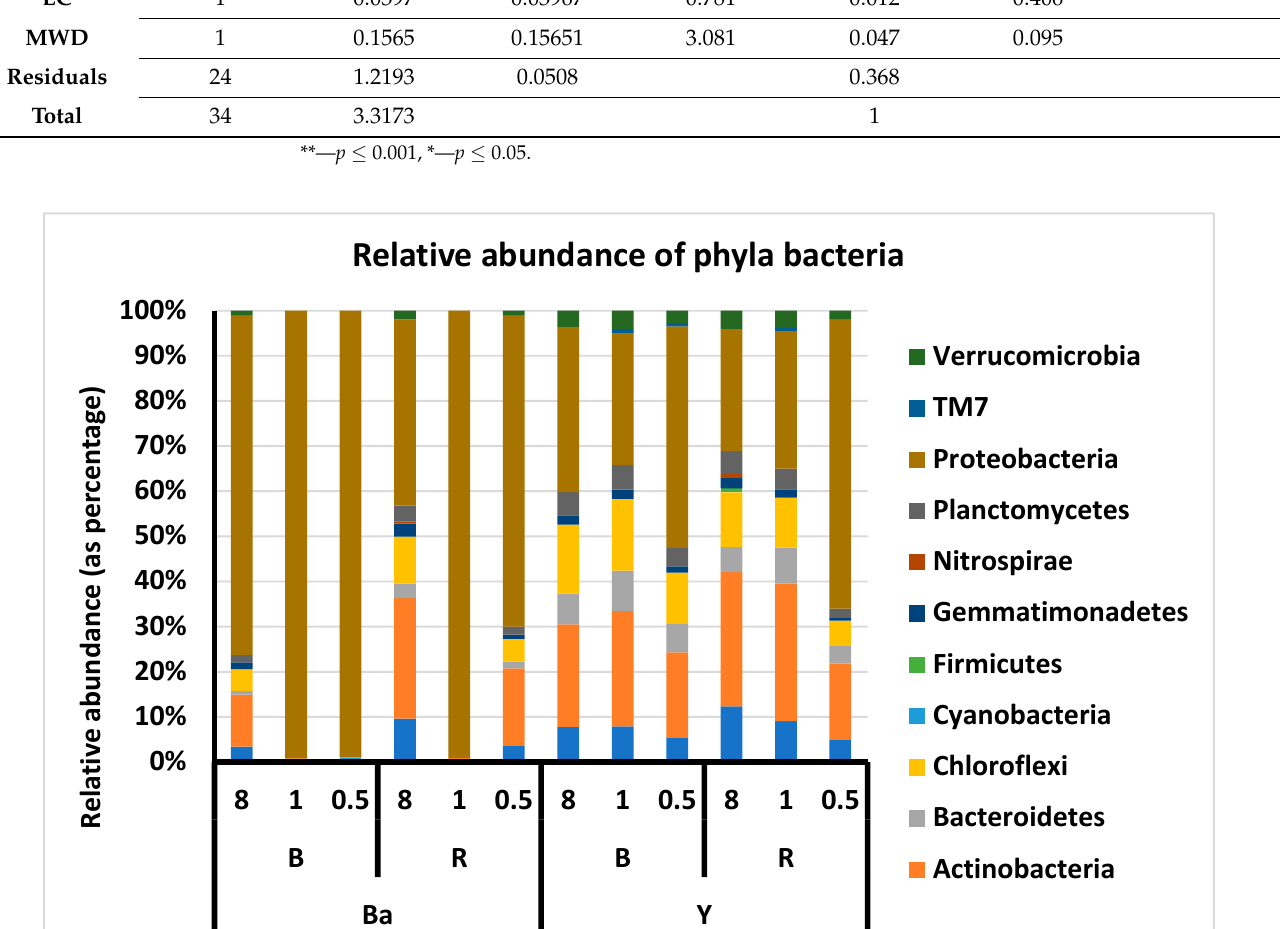
conventional (Ba); at different sampling locations: between (B) the plant rows and in vine rows (R)